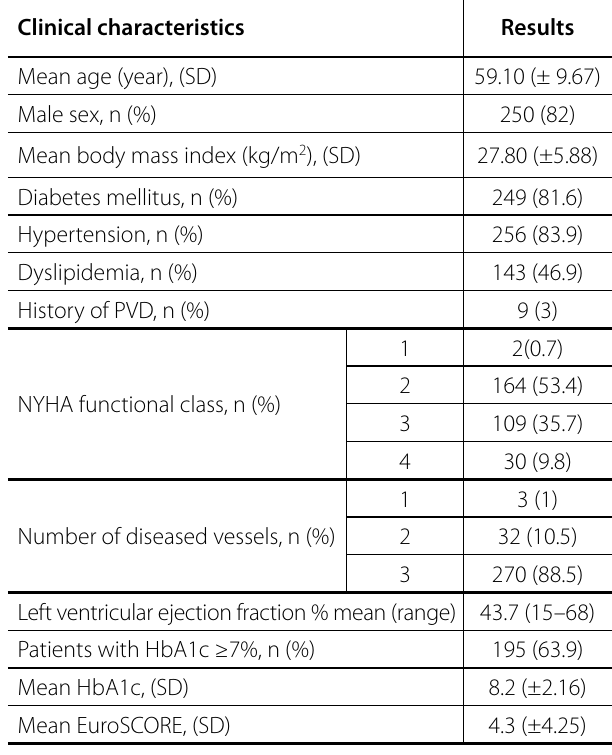
Table 1. Clinical characteristics of CABG patients (all patients n=305).